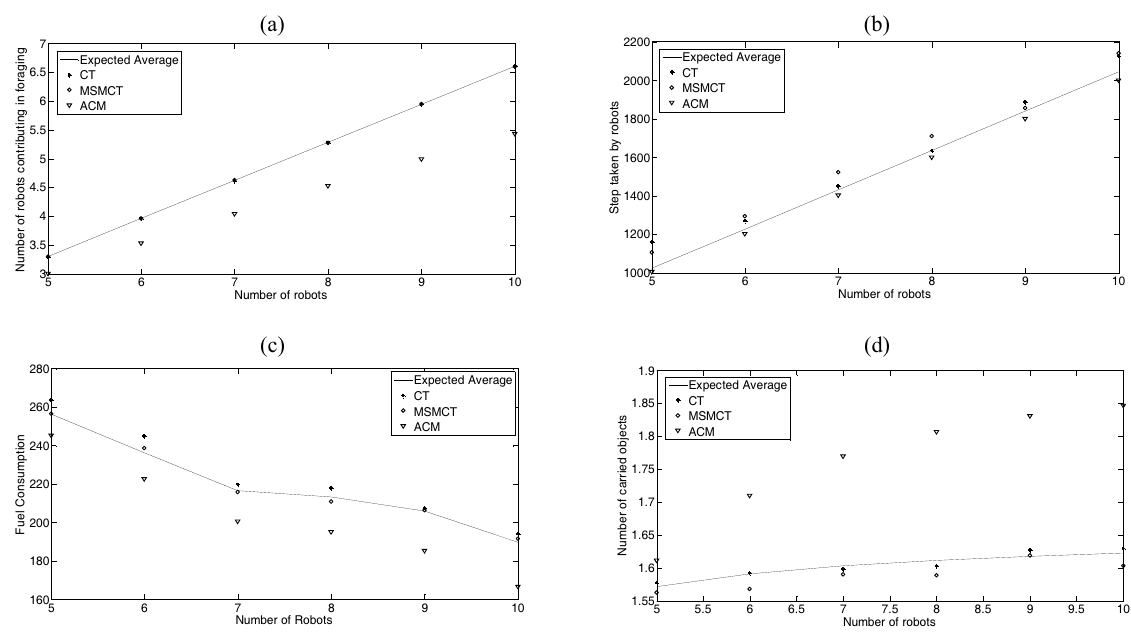
Fig. 14. Monte Carlo simulations of a two-object system. Simulations had run for R =5, ...,10 robots; each for 50 times with random selection of initial position of